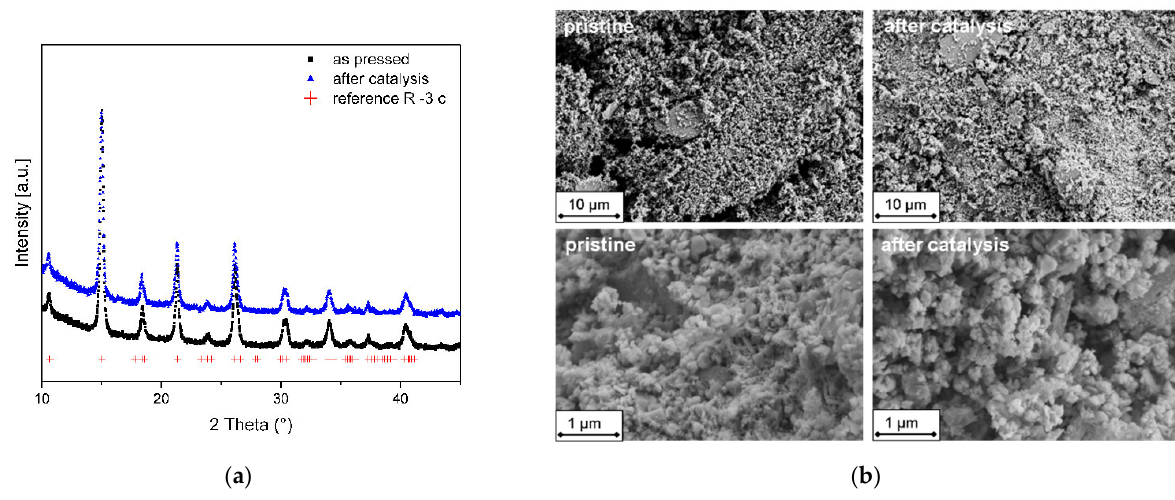
Figure 6. ( a ) XRD patterns of the powdered catalyst before (as pressed) and after catalysis. All reflections can be assigned to a rhombohedral perovskite (space group R ‐ 3 c), reference positions adapted from Crystallography Open Database (COD) entry 1525854 [34]. ( b ) SEM images in SE mode of the same powders in 5 k× and 50 k× magnification.